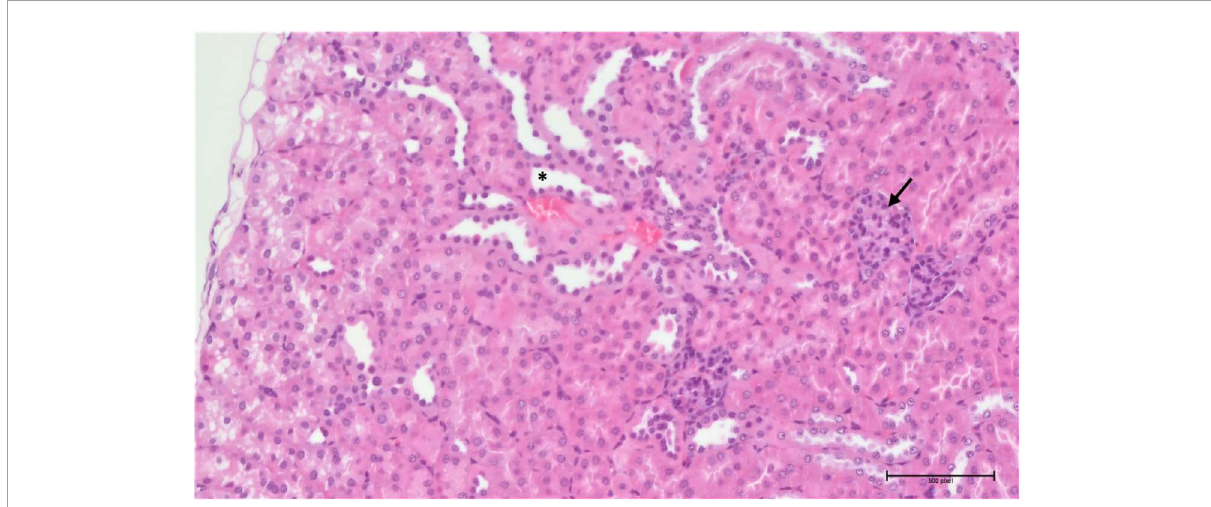
FIGURE14 Group 3/25 – kidneys (HE, 200 × ): narrowing of Bowman’s space (arrow), focal tubular atrophy (asterisk).